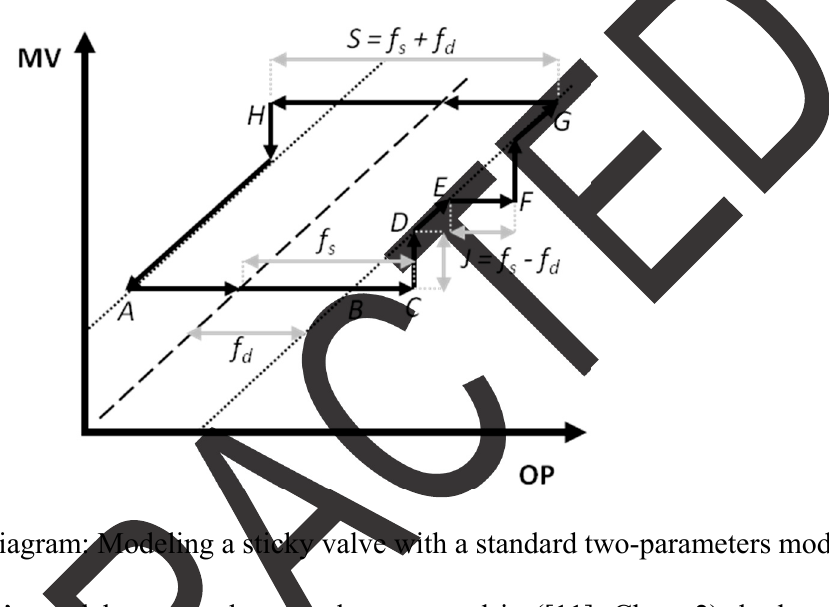
Figure 2. MV(OP) Diagram: Modeling a sticky valve with a standard two-parameters